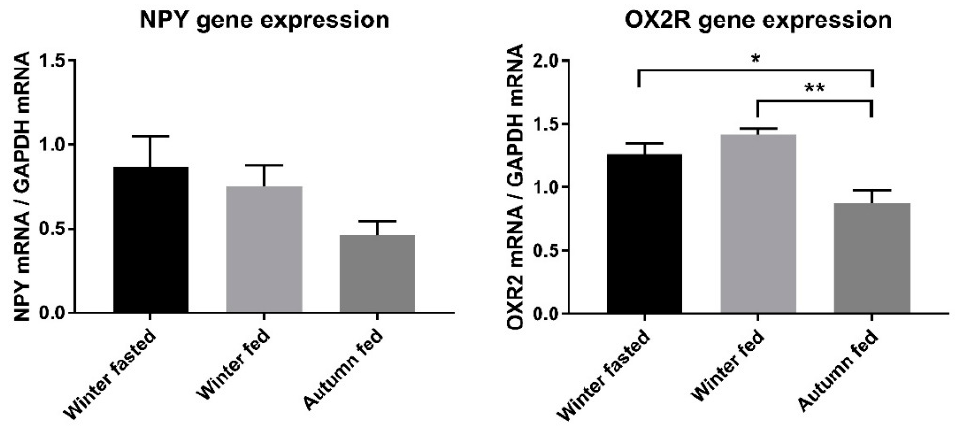
Figure 1. Relative mRNA level expression of orexigenic NPY and OX2R normalized to the expression of GAPDH in raccoon dog hypothalamus. Statistically significant differences are indicated with * p < 0.05, and ** p ≤ 0.01.